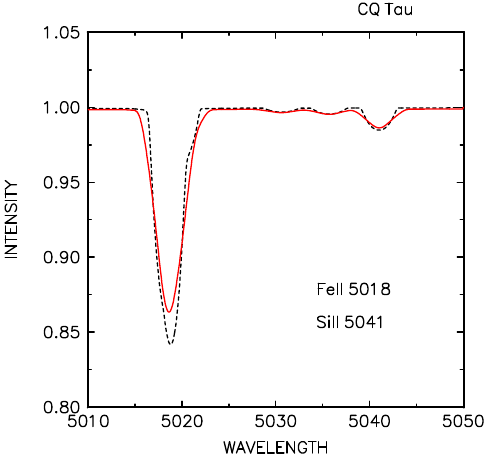
Figure 5. A part of the synthetic spectrum of CQ Tau in the vicinity of the Fe II 5018 Å line in the bright state (black) and the deep minimum